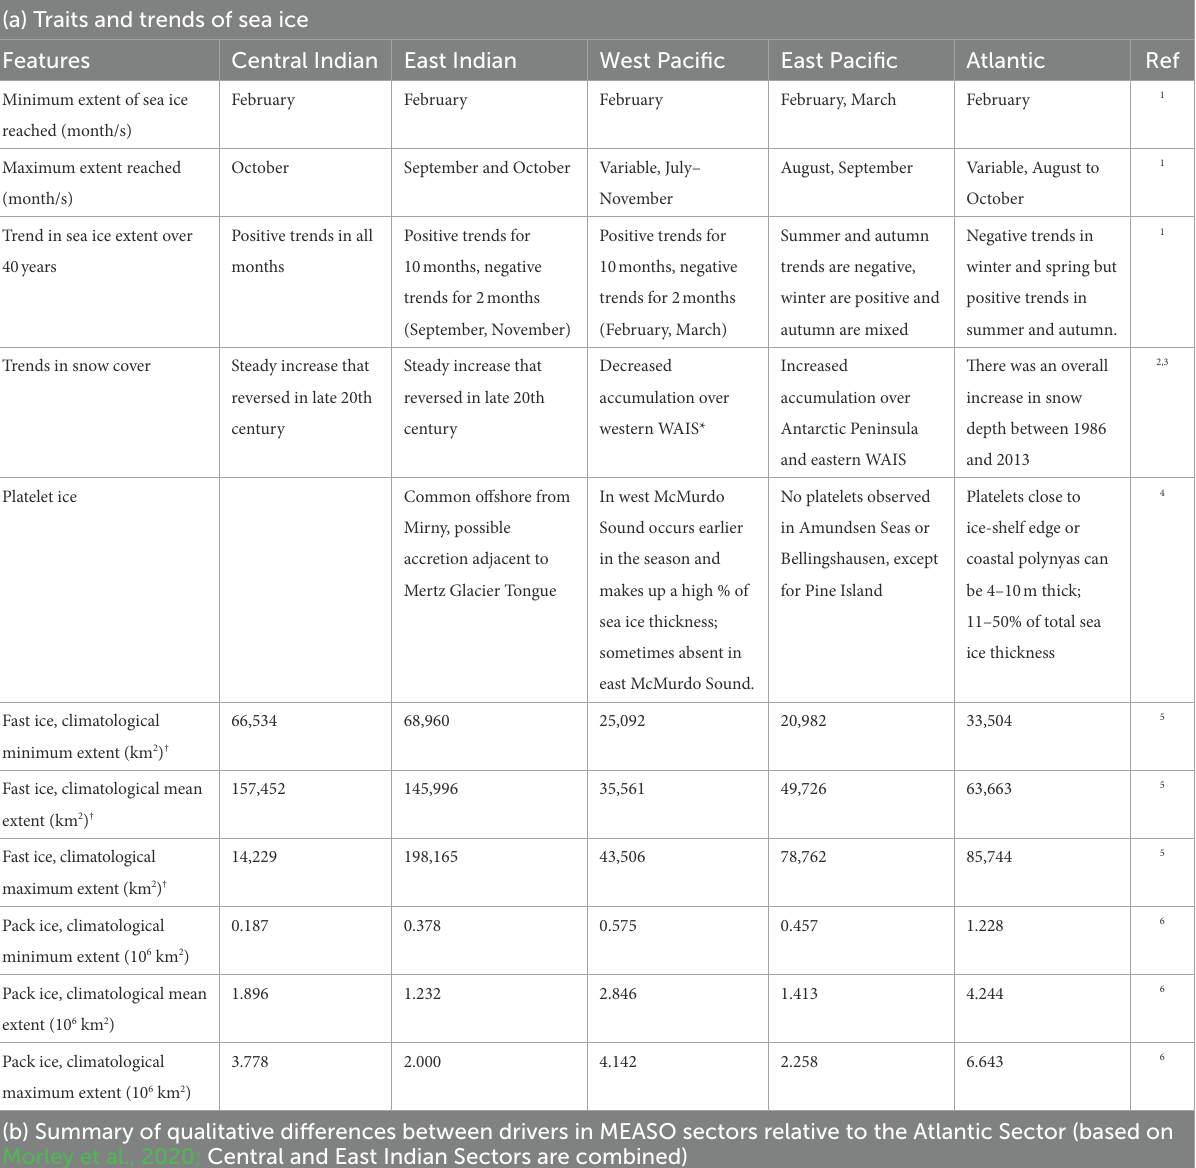
TABLE 1 Summary of the variation in physical factors of Antarctic sea ice between MEASO sectors (see Figure 2). (a) Traits and trends of sea ice